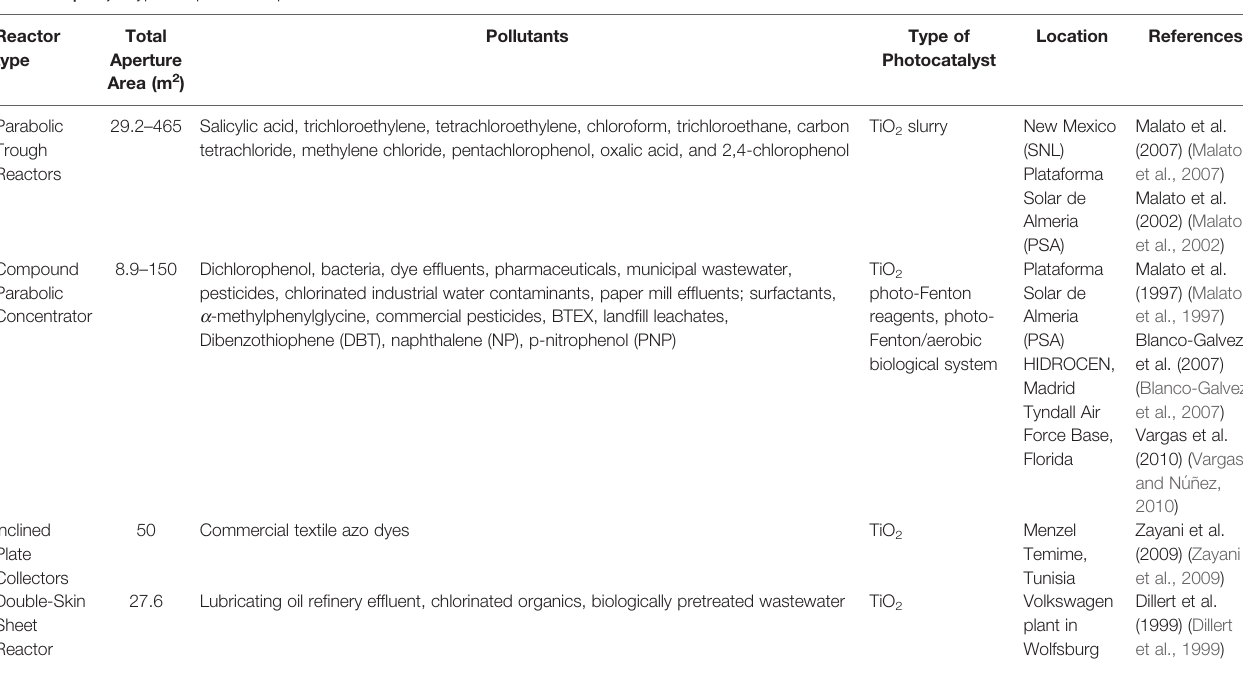
TABLE 5 | Major types of pilot-scale